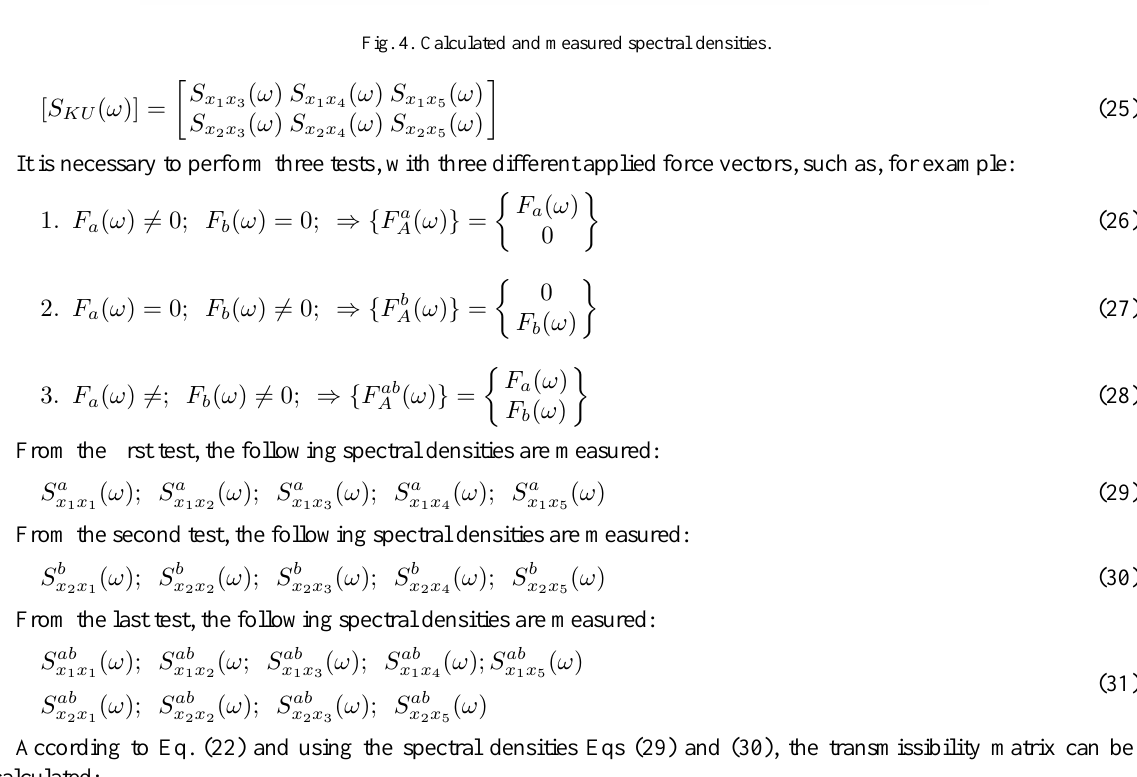
Fig. 4. Calculated and measured spectral